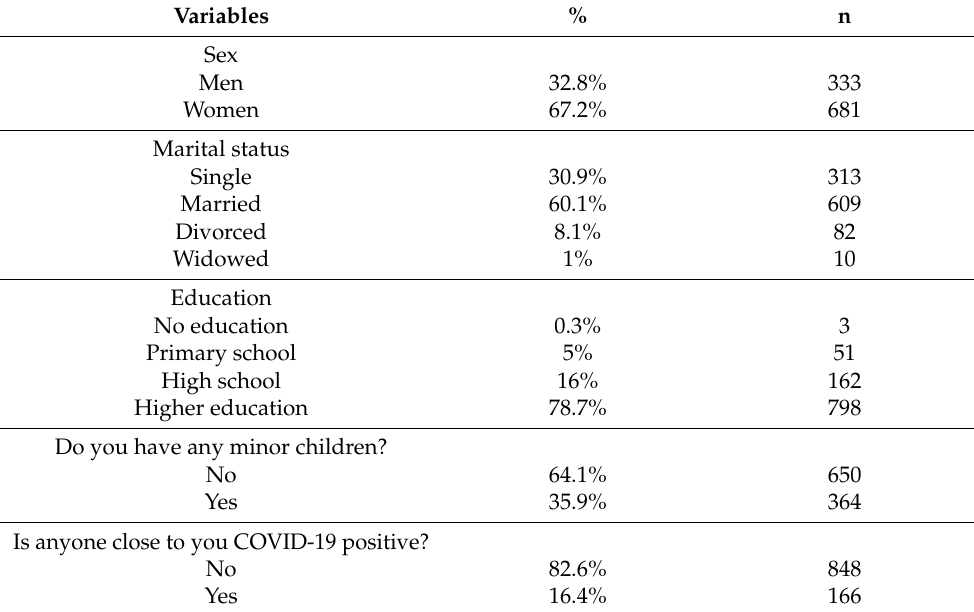
Table 2. Sociodemographic characteristics of the